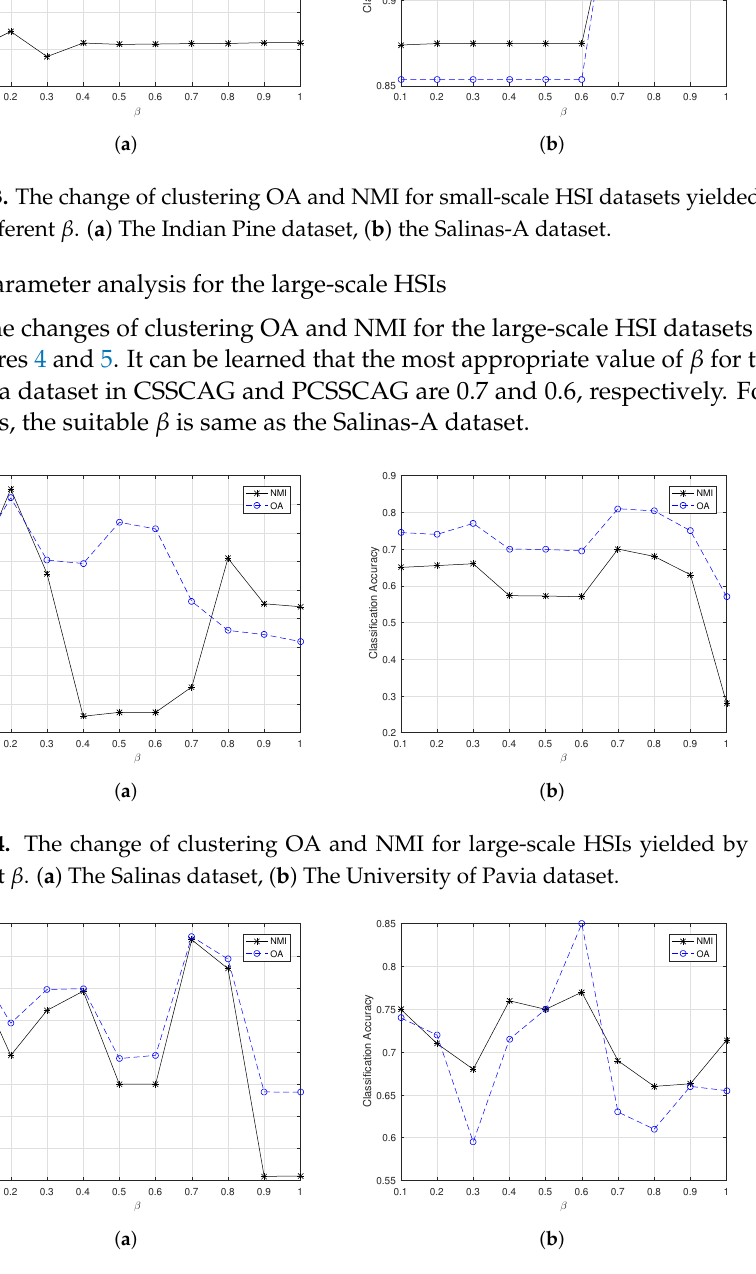
Figure 5. The change of clustering OA and NMI for large-scale HSIs yielded by PCSSCAG with different β . ( a ) The Salinas dataset, ( b ) the University of Pavia